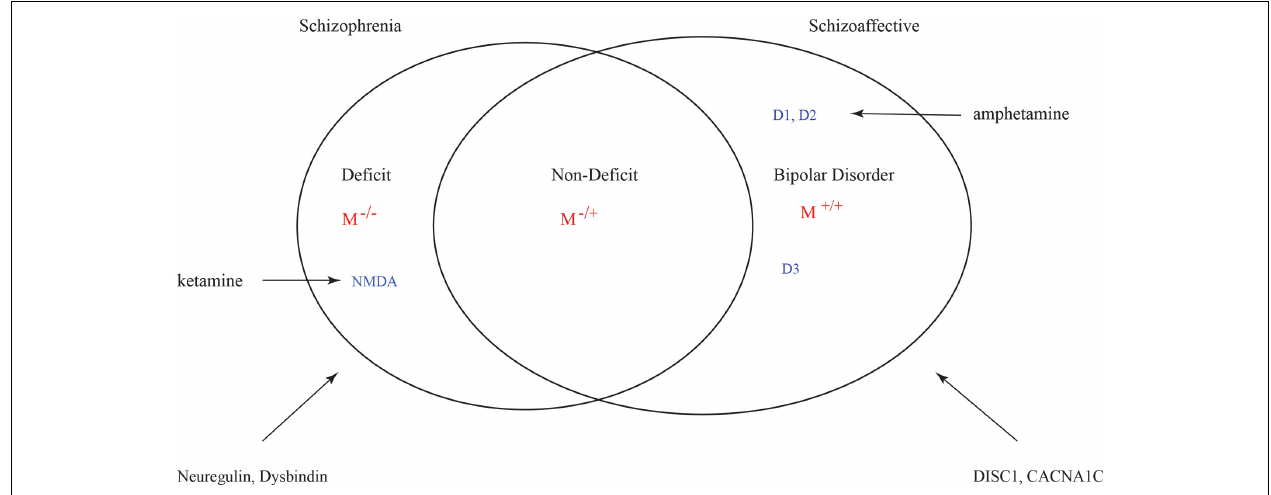
FIGURE 9 |Venn diagram for a nosology of psychosis. M represents the relative muscarinic deficit and correlates with primary negative symptoms. D, dopamine receptor subtypes. D3 sensitizes M receptor function. Across the spectrum dopamine-muscarinic imbalance results in an overlapping phenotype in positive